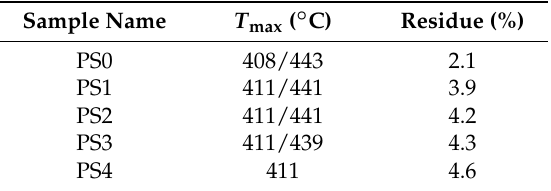
Table 3. The Thermogravimetric parameters for PS1–4